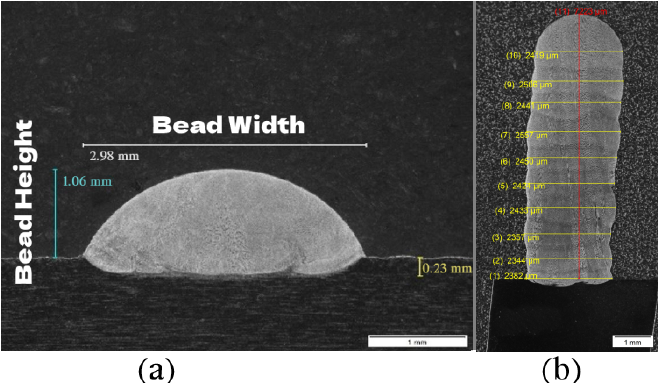
Figure 3. ( a ) Single bead geometry measurements. ( b ) Layer deposition